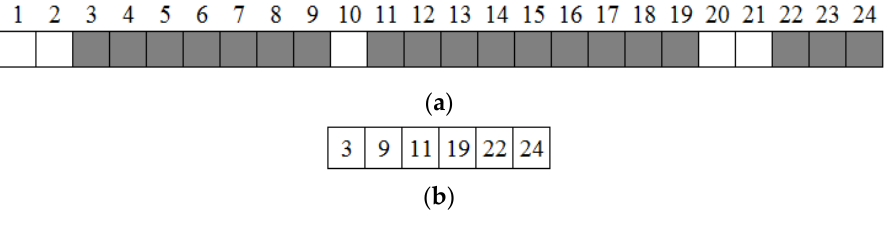
Figure 1. ( a ) On (grey) and off (white) states of a generator over 24 h; and ( b ) new encoding.